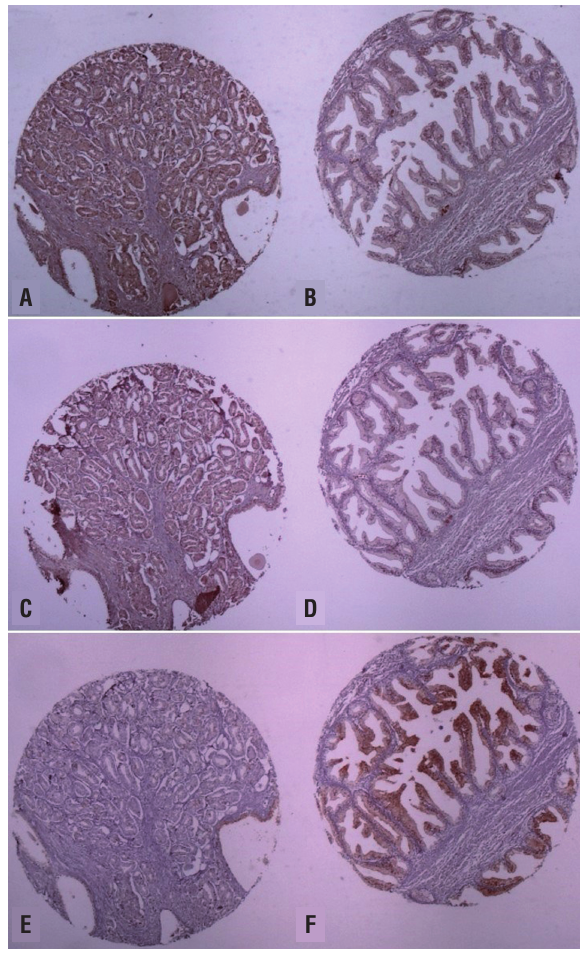
IL8 were expressed by 47.2%, 0.0%, 65.7%, 63.9% of the cases respectively (Figures 1 and 2). figure 1 - photomicrograph illustrating immunohistochemical reactions. A: positive reaction of MMp-9 in cancer tissue; B: negative reaction of MMp-9 in normal prostate tissue; C: positive reaction of MMp-2 in prostate cancer; D: negative reaction of MMp-2 in normal prostate tissue; E: negative reaction of TIMp-1 in prostate cancer; f: positive reaction in control